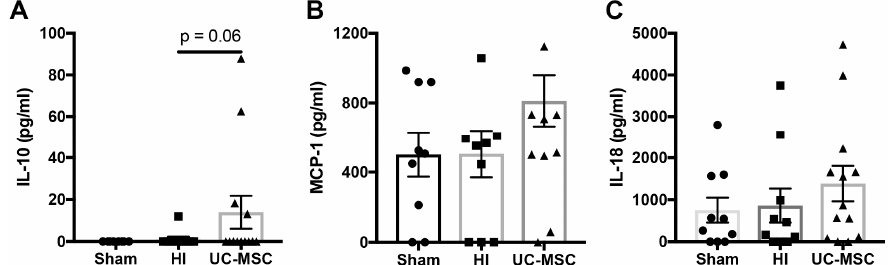
Figure 6. Cytokine analysis of serum following neonatal HI brain injury. ( A ) Interleukin (IL)-10 concentration; ( B ) monocyte chemoattractant protein (MCP)-1 concentration; ( C ) IL-18 concentration. ( n = 10–13 rats per group).